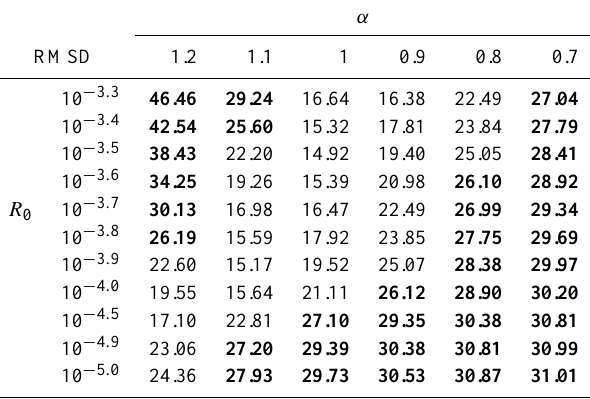
Table 5. Pearson correlation coefficients among X trend and X theor values obtained for the case of 5 September 2012. Bold values are less than the obtained mean value. Pearson correlation